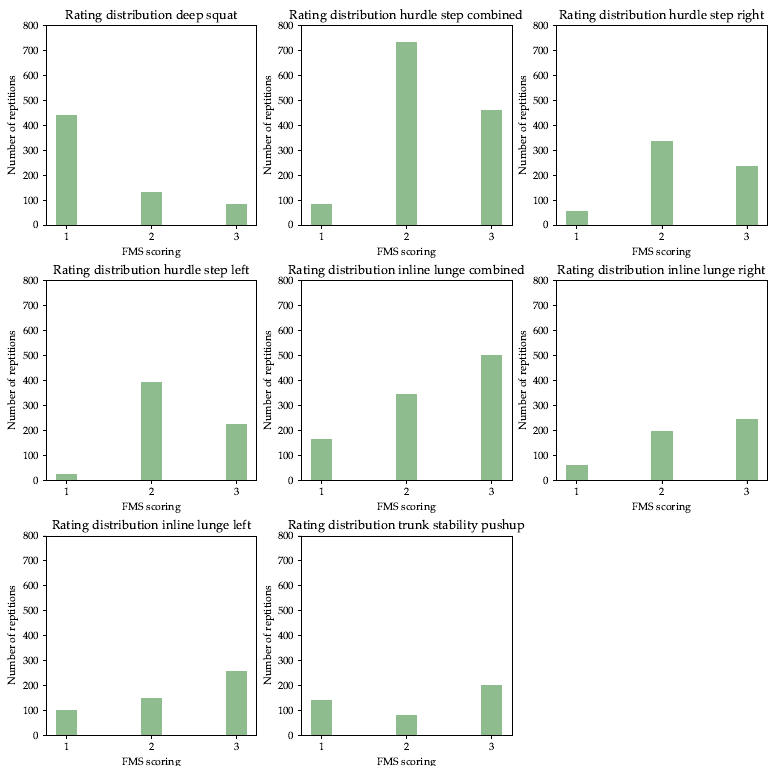
Figure 9. Distribution of the assigned FMS ratings (“1”, “2” or “3”) divided by exercise. HS and IL can be performed with an active left or right foot and are therefore split into, e.g., “HS right” and “HS left”. The distribution over both left and right repetitions is presented with the label “combined”, e.g., HS